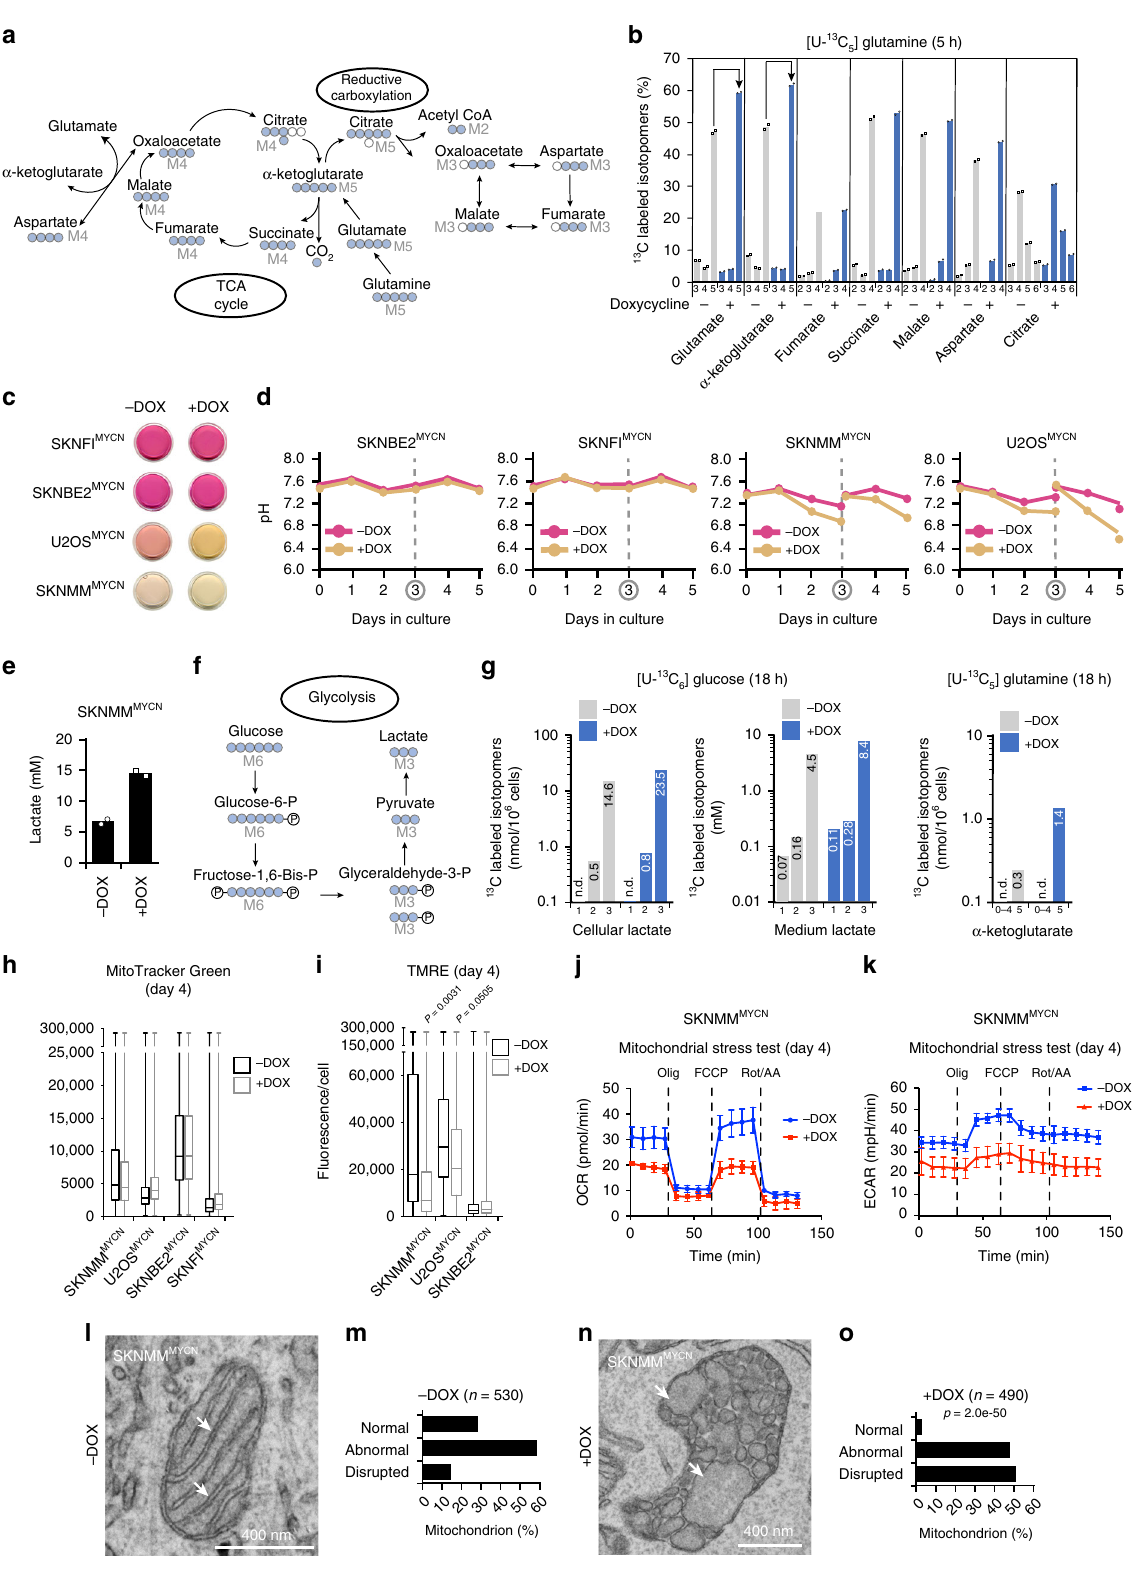
(Fig. 6a). For every H3.3 peak in the data set, we assigned it to